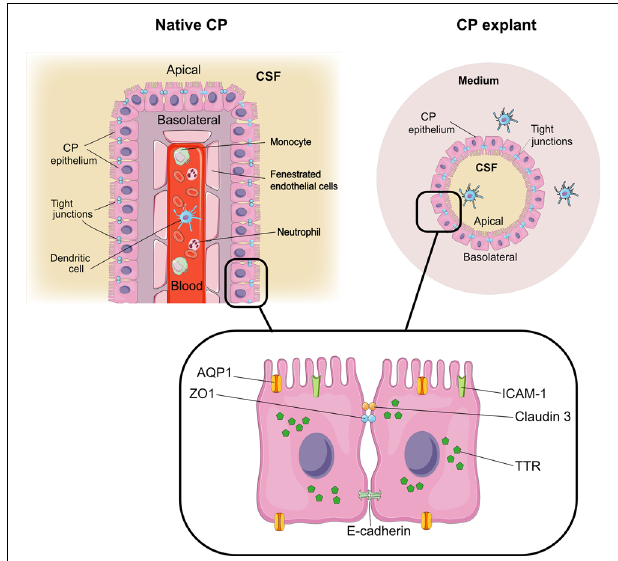
FIGURE 7 | CP explants as a model to study interactions with immune cells. Comparison of architecture in native CP and CP explants. The graphical elements were modified from SMART SERVIER MEDICAL ART, Les Laboratoires